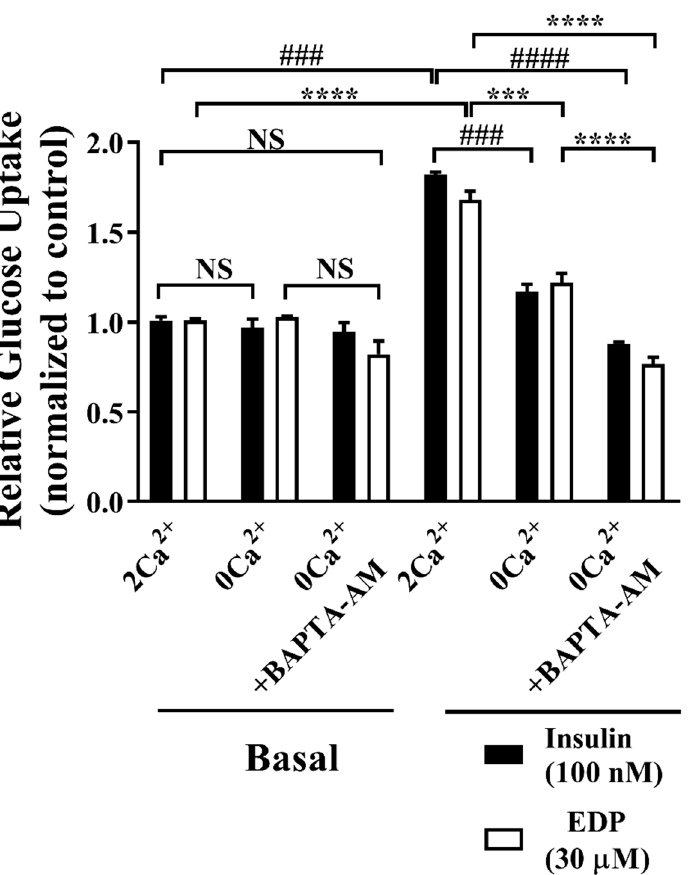
Figure 6. Intracellular Ca 2+ promotes EDP-induced uptake of glucose. EDP-stimulated uptake of glucose in the presence of different concentrations of Ca 2+ within 30 min. NS p > 0.05; ### p < 0.001, #### p < 0.0001 indicates comparison between blank and insulin group, and *** p < 0.001, **** p < 0.0001 indicates comparison between blank and EDP group.